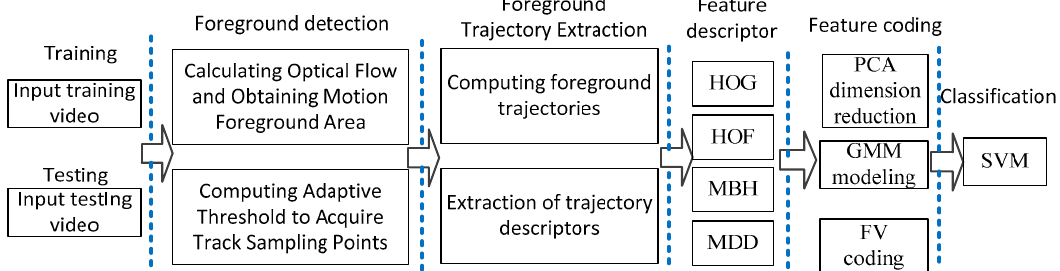
Figure 1. Flow chart of the human behavior recognition algorithm. HOG, histogram of oriented gradient; HOF, optical flow; MBH, motion boundary histogram; MDD, motion difference descriptor; PCA, principal component analysis; GMM, Gauss mixture model; FV, Fisher vector; and SVM, support vector machine.